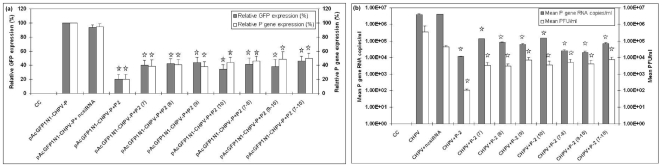
Tolerance of RNAi for mismatches in the P-2 siRNA relative to target mRNA.Tested in vitro by using (a) pAcGFP1N1-CHPV-P plasmid and (b) CHPV. Results are expressed as means ± SD. * indicates significantly different from control at p<0.05 by Dunnett's test.